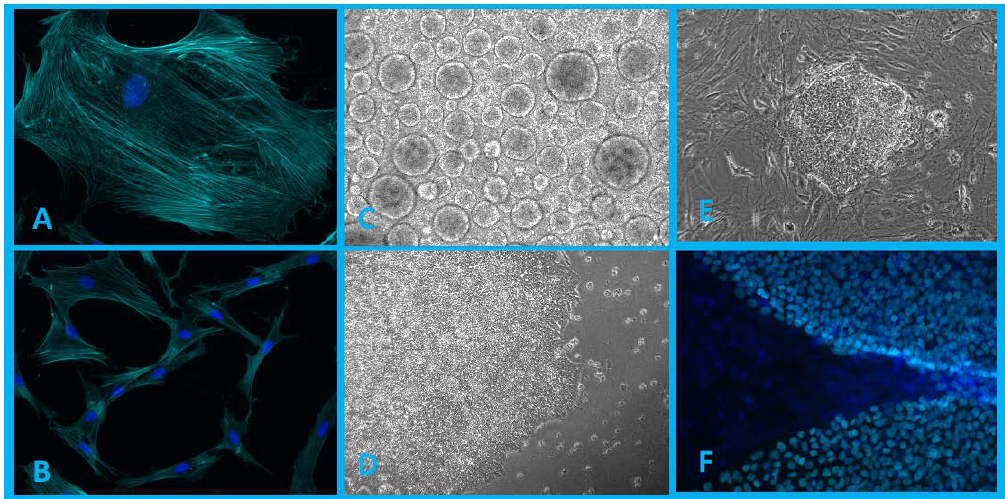
Figure 1. ( A , B )—Population of human dermal fibroblasts isolated from patient biopsy (blue, DAPI; cyan, phalloidin). ( C )—Embryoid bodies formed in 3D cultivation conditions. ( D , E )—iPSC colonies in 2D cultivation conditions. ( F )—iPSC colonies grown on a layer of mouse embryonic fibroblasts (MEFs) (blue, DAPI; cyan, expressed transcription factor Nanog). Authors’ own images.